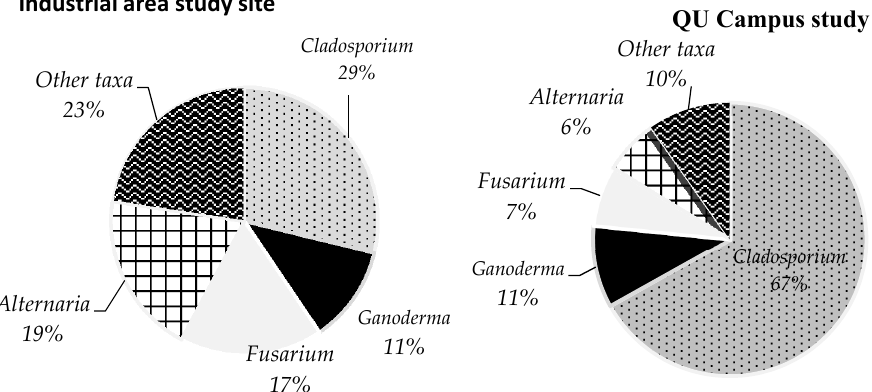
Figure 6. Pie graph to show the main constituents of fungal genera and their relative abundances in the atmosphere of the two study sites during the period of 1 February to 31 March 2016, with a total of 22 exposure samplings.